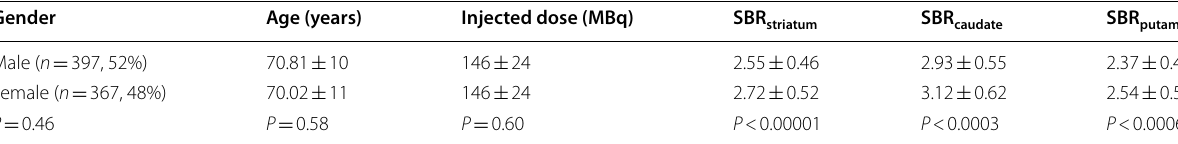
Table 1 Characteristics according to gender Gender